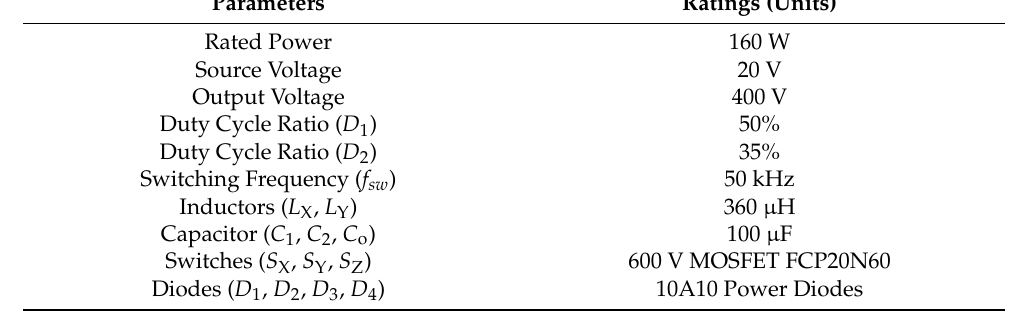
Table 2. Proposed converter’s design parameter. Figure 8. Proposed converter’s hardware prototype setup. Table 2. Proposed c onverter’s design parameter.